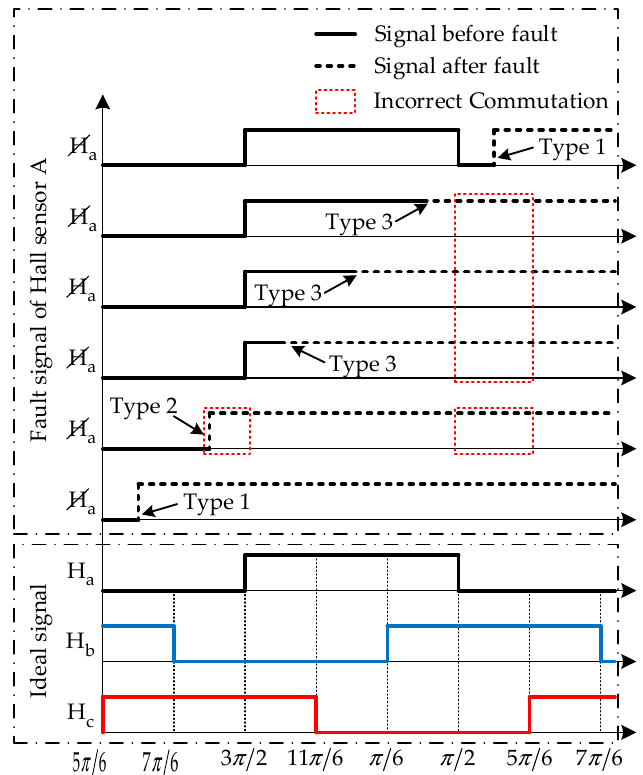
Figure 2. Examples of faults in Hall Sensor A at six different sectors (Signal H a changes to